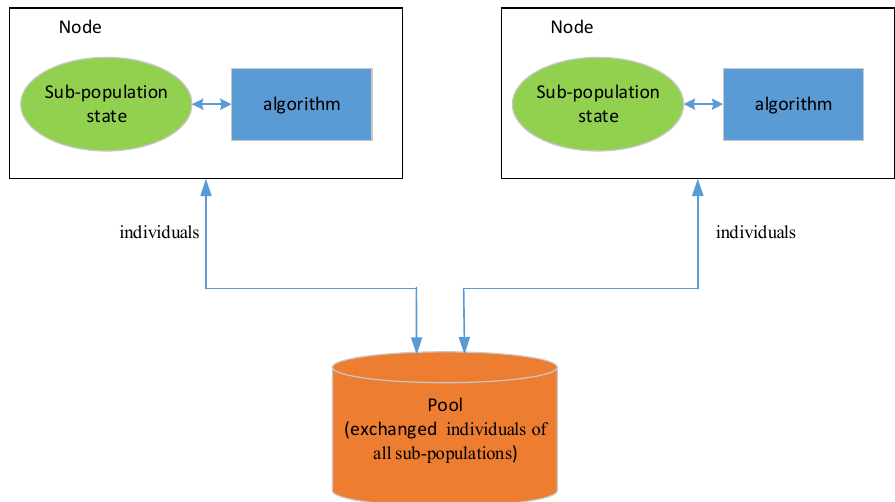
Figure 7. Communication between nodes in the Pool model.